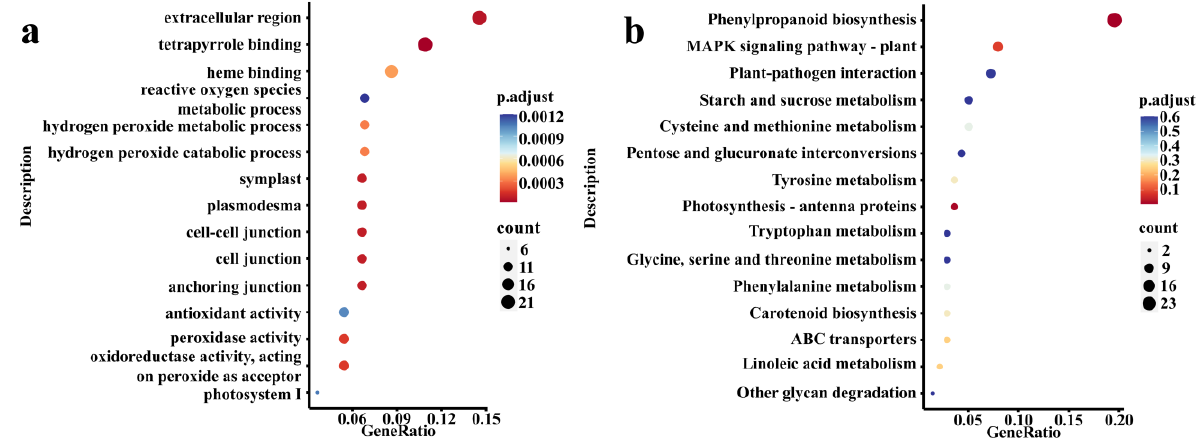
Figure 3. ( a ) The scatter map of GO enrichment analysis on 661 DEGs obtained by WGCNA. Sorted by p.adjust (from 0 to 1), the top 15 GO enrichment results were selected to display. ( b ) The scatter map of KEGG enrichment analysis on 661 DEGs obtained by WGCNA. Sorted by p.adjust (from 0 to 1), the top 15 KEGG enrichment results were selected to display. Gene ratio: A score, the numerator is the number of genes enriched in this GO entry and the denominator is the number of input genes for enrichment analysis, which can be the genes obtained by differential expression analysis; count: enter the number of genes enriched to this GO entry in the genes for enrichment analysis; p.adjust: corrected P value. For the complete GO and KEGG enrichment results, please view Tables S3 and S4.